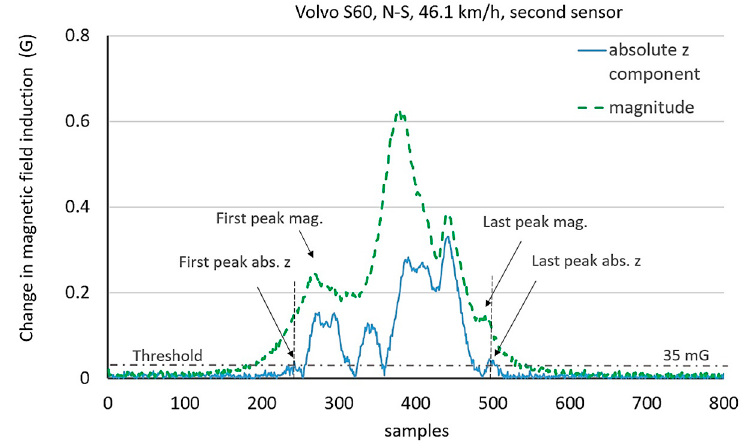
Figure 8 . The problem of different numbers and positions of peaks considering the absolute z-component and the magnitude of magnetic field induction.